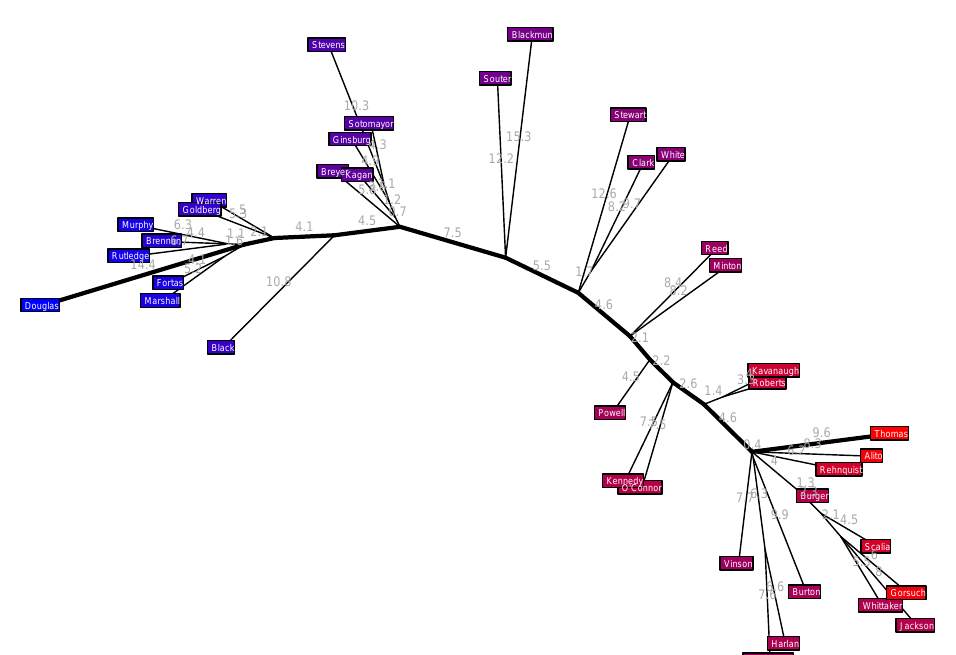
Figure 16. Judicial tree with all 38 justices who served on the Court between 1946 and 2020 computed from the low-rank matrix completion in Figure